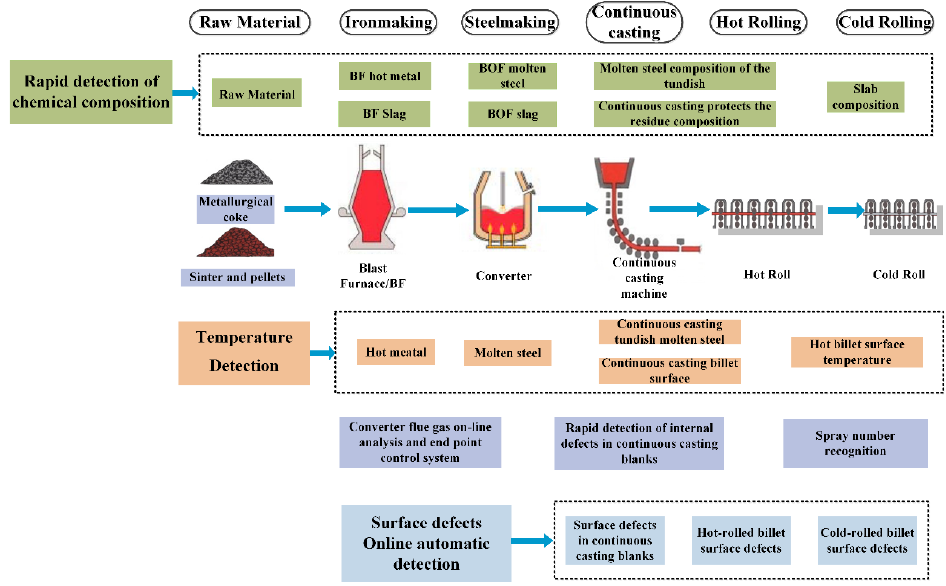
Figure 3. Online detection technologies used in China’s steel industry.